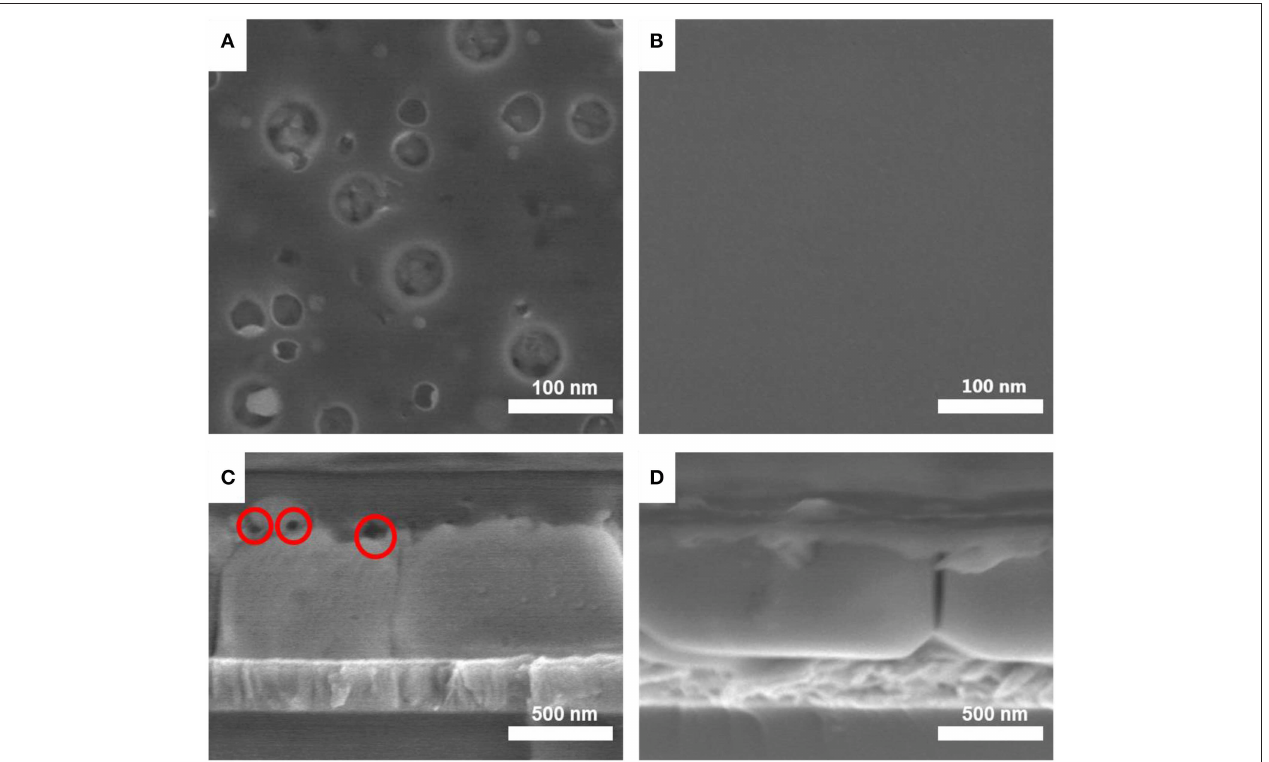
FIGURE 2 | The top view SEM images of (A) CB-Spiro and (B) EDT-Spiro films as well as the cross-sectional SEM images of (C) the CB-Spiro and (D) EDT-Spiro films deposited on the perovskite films.